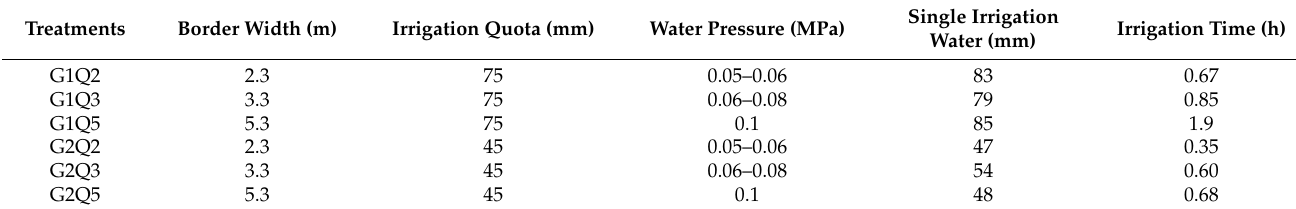
Table 2. First-year boundary test design scheme.